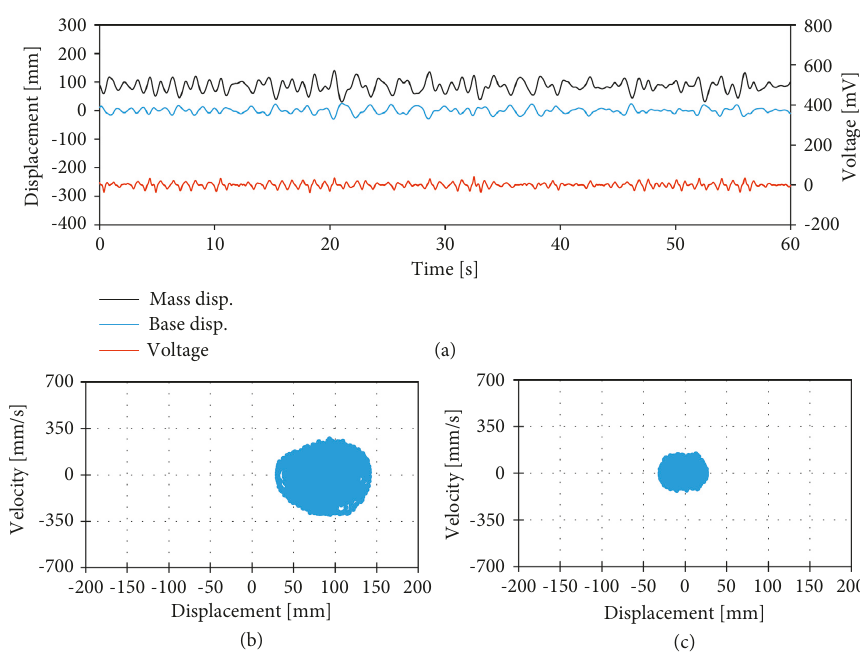
Figure 7: Measured results for response vibration displacement and vibration power generation for vibration with a random signal. (a) Response vibration displacement results. (b) Diagram of displacement vs. velocity of vibration for the mass block. (c) Diagram of displacement vs. velocity of vibration for the support.